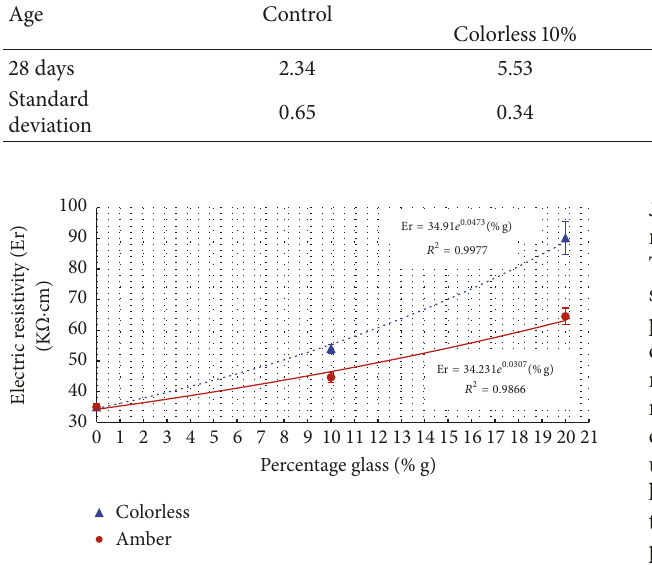
Figure 5: Results of electrical resistivity test in mortars, 28